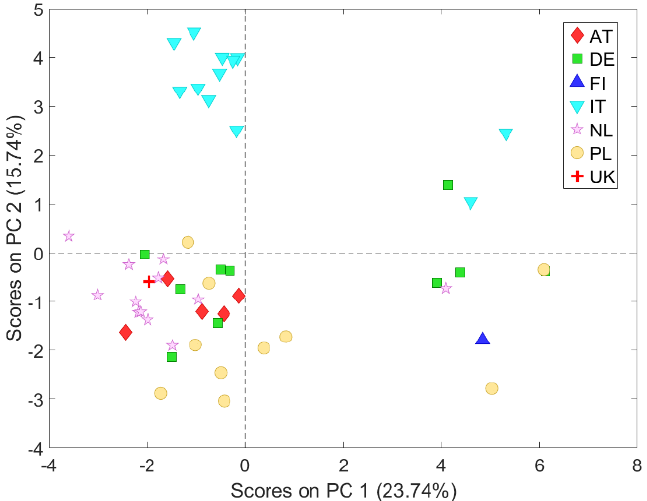
Figure 2. Score plot of PC1 and PC2; farm countries in evidence. The group on the left topside consists of 10 out of the 12 Italian heavy pig farms (Figure 2), whose positions in the score plot, compared to the corresponding loading plot of Figure 1, reveals that they are characterized by higher live weight at slaughter (LWS), feed conversion ratio (FCR), mortality rate (M), number of pigs per drinker (PD) and the presence of liquid feeding system (LFS). The other two Italian heavy pig farms are organic and represented correctly on the right side of the score plot. Based on the results of the PCA model, which highlighted the presence of three separate farm clusters (Figure 2), the contribution of each single variable to this grouping was explored by checking for statistically significant differences between clusters: